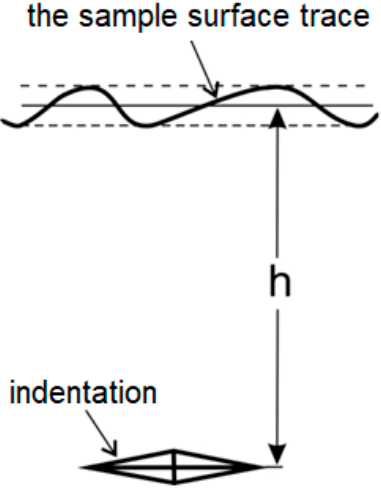
Figure 2. A schematic illustration of microhardness measurement procedure.